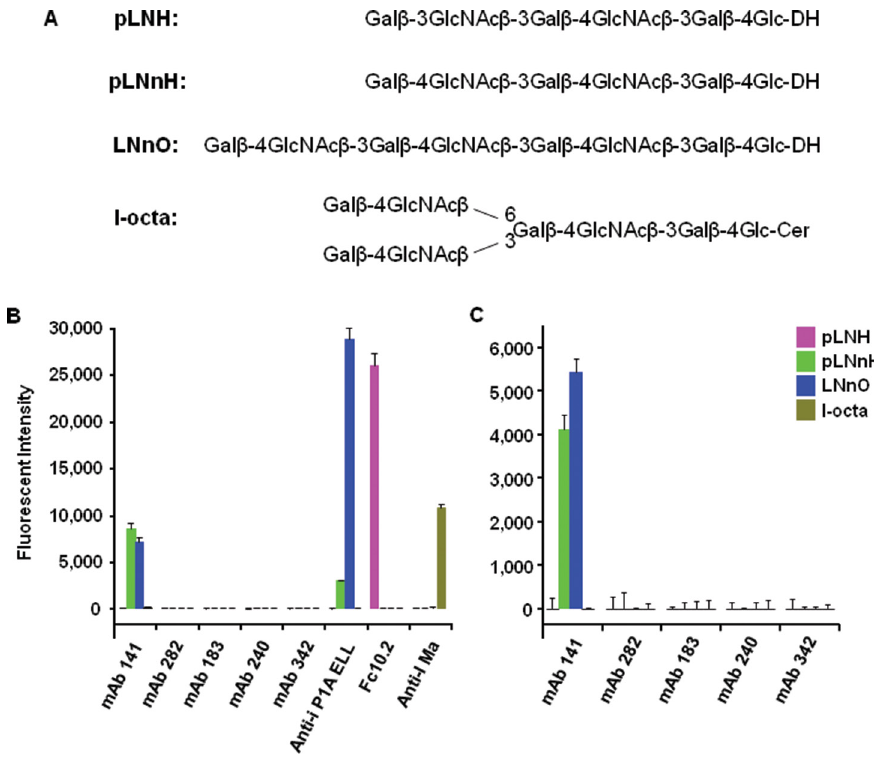
Figure 3. CLL subset 4 IGs do not bind i or I carbohydrate antigens. (A) Glycan sequences of the lipid-linked oligosaccharides pLNH, pLNnH, LNnO and I-octa that were among 76 additional (i- and Fc10.2- antigen-negative probes) in the microarray. Abbreviations: Gal, galactose; GlcNAc, N-acetylglucosamine; Glc, glucose; DH, L-1,2-dihexadecyl- sn -glycero- 3-phosphoethanolamine; Cer, ceramide. (B), (C) Microarray analysis of CLL mAbs 141, 282, 183, 240, and 342, in either (B) native bivalent or (C) precomplexed condition. The human anti-i IgM PIA ELL, human anti-I Ma, and the murine IgM Fc10.2 were included as positive controls. The results are the means of fluorescence intensities of duplicate spots, printed at 5 fmol, with error bars representing half the difference between the two